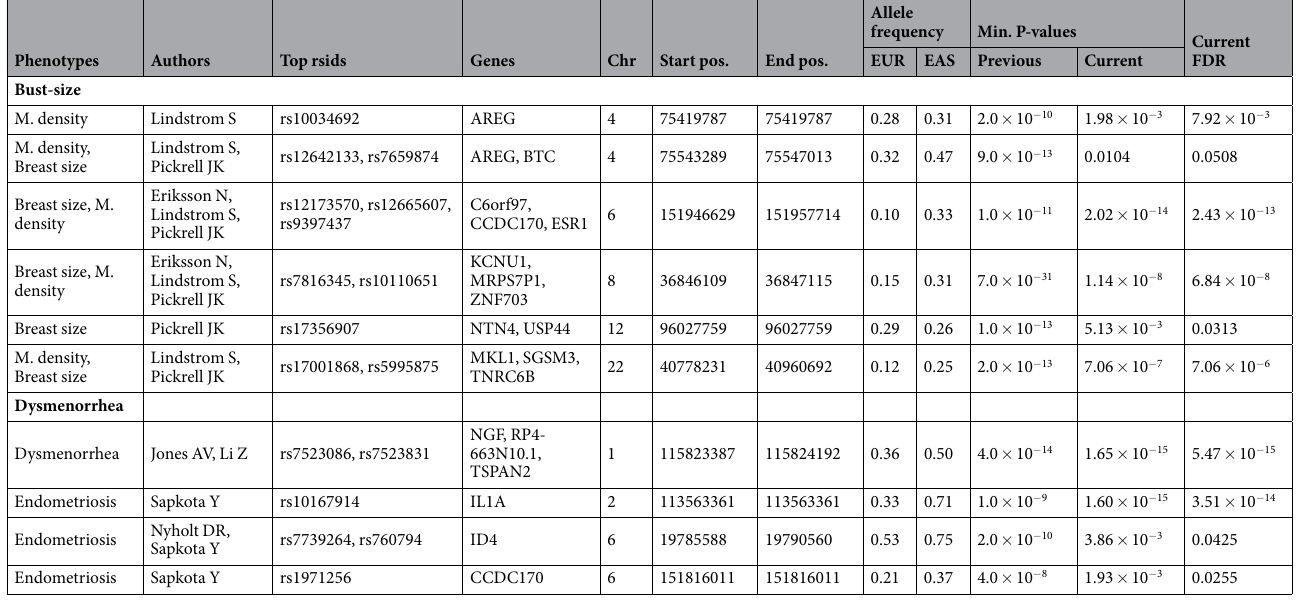
Table 2. Previously reported bust-size and dysmenorrhea-related associations. We summarize results from the current study for previously reported bust-size related associations (Breast-size or Mammographic density) and dysmenorrhea-related (Dysmenorrhea or mammographic density) from the NHGRI/EBI GWAS Catalog (downloaded 8/31/2017). Current study results were from the genome-wide summary statistics based imputation for reported loci that previously achieved P < 5 × 10 − 8 . Ordered by chromosome and FDR in current